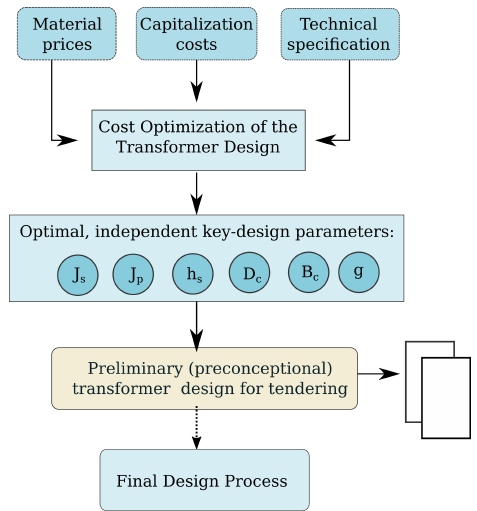
Figure 1. Schematic view of a large power transformer design process.